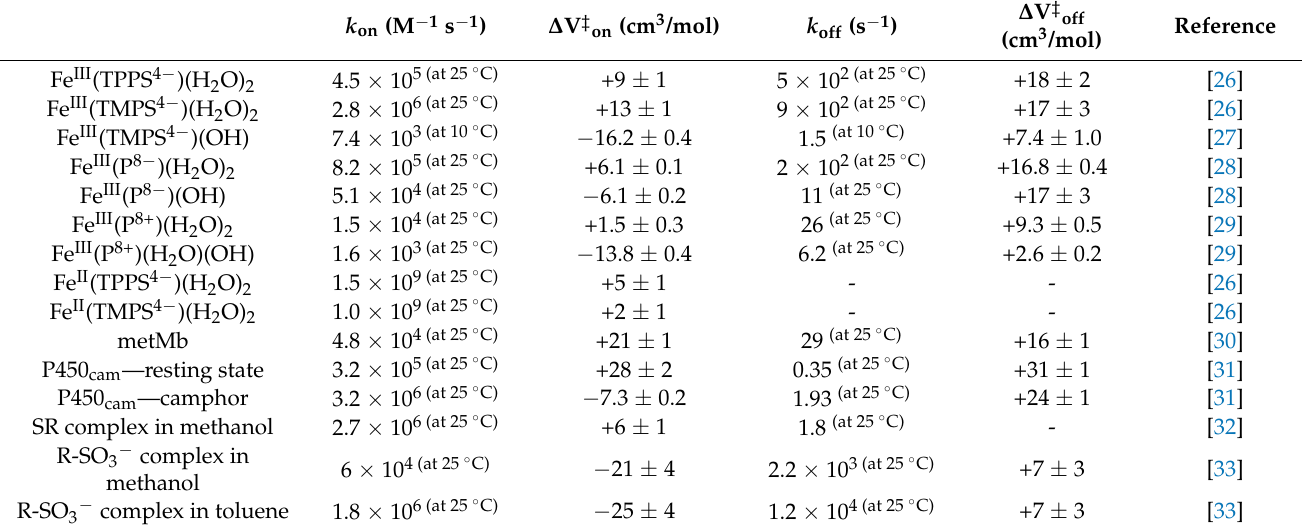
Table 1. Rate constants and activation volumes for the reactions of selected iron porphyrins and heme proteins with NO.